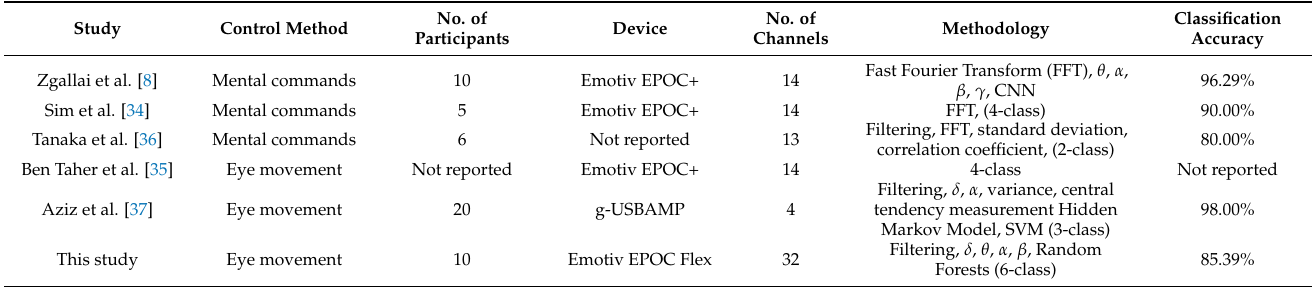
Table 2. A comparison of the performances of the various methods proposed in the literature for wheelchair navigation. Study Control